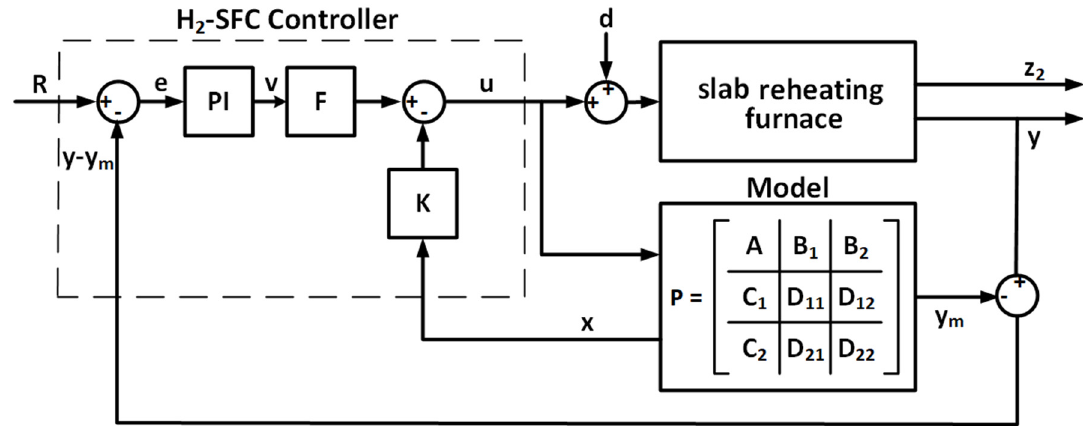
Figure 5. Block diagram of the heating zone temperature control system of the slab reheating furnace under study with the designed H 2 state feedback controller (H 2 -SFC) controller.